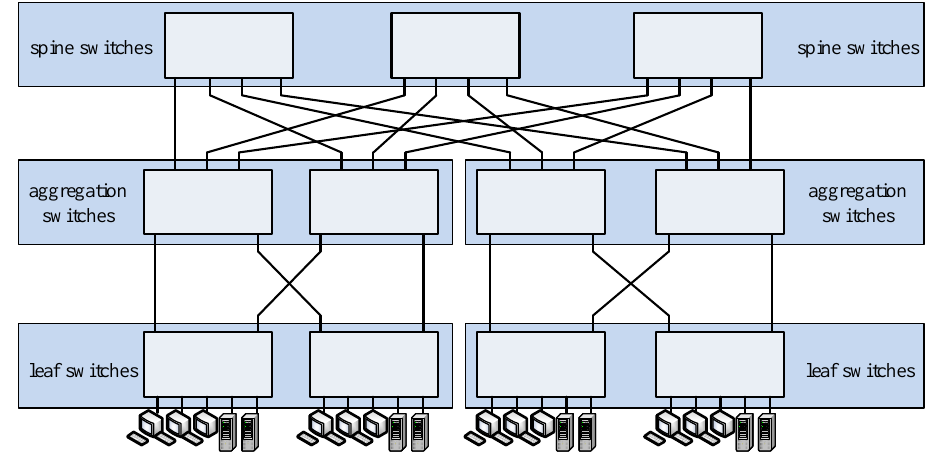
Figure 4. A five-stage Clos topology of a data